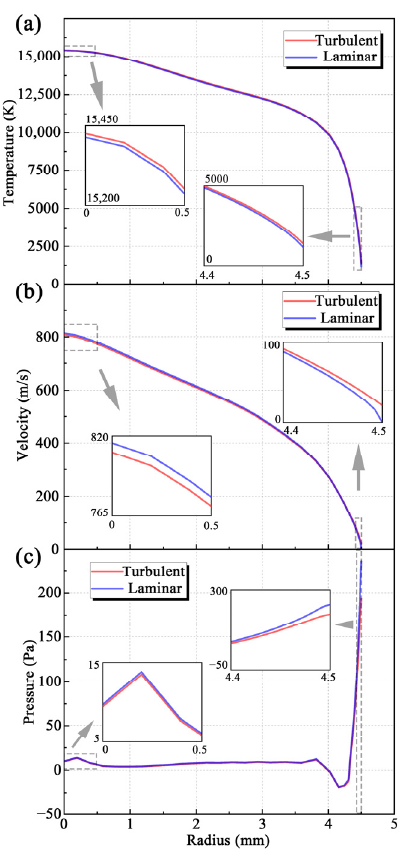
Figure 4. Calculated ( a ) temperature, ( b ) velocity, and ( c ) pressure (relative to 101,325 Pa) profiles at the nozzle exit of SinplexPro™ plasma spray gun (nozzle radius 4.5 mm).